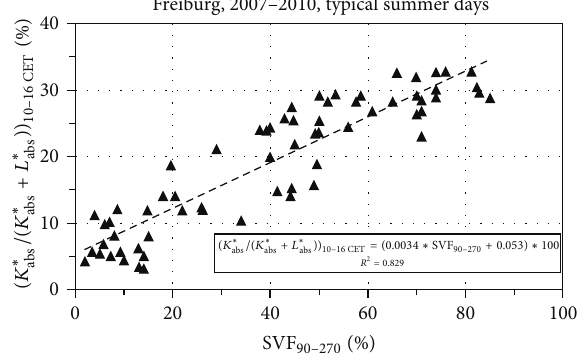
Figure 25: Relationship between mean values (10–16CET) of 𝑇 and SVF 90 , based on human-biometeorological measuring mrt – 270 campaigns at different sites in Freiburg on typical summer days 2007–2010